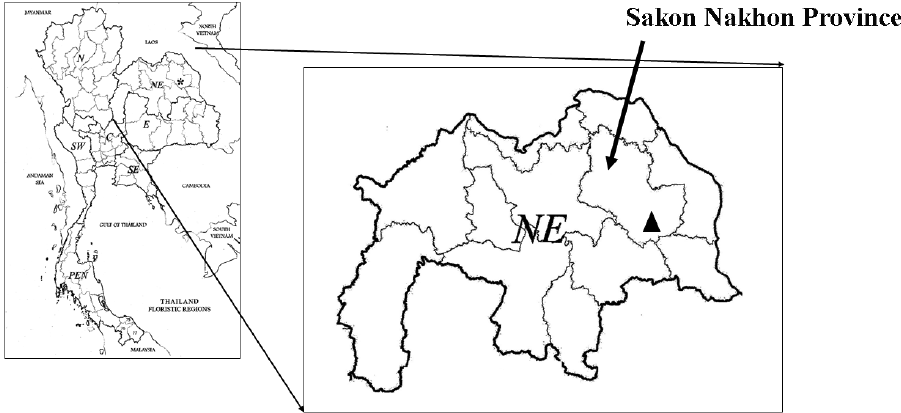
Figure 3. Distribution of Dischidia phuphanensis (black triangle) in Phu Pha Yol National Park, Sakon Nakhon Province,